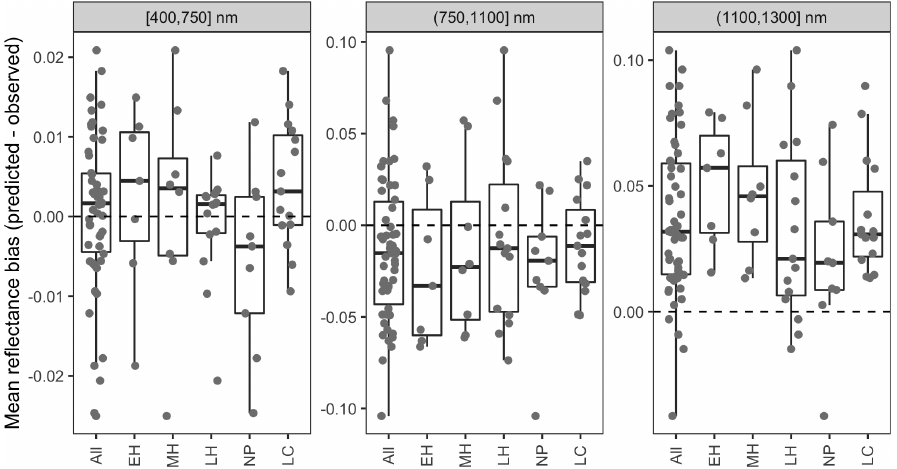
Figure 5. Differences between AVIRIS-observed and EDR posterior predictive mean surface reflectance by site, averaged across wavelength regions. Sites are grouped by dominant PFT, as in Fig. 4. Note the differences in the y -axis scale across